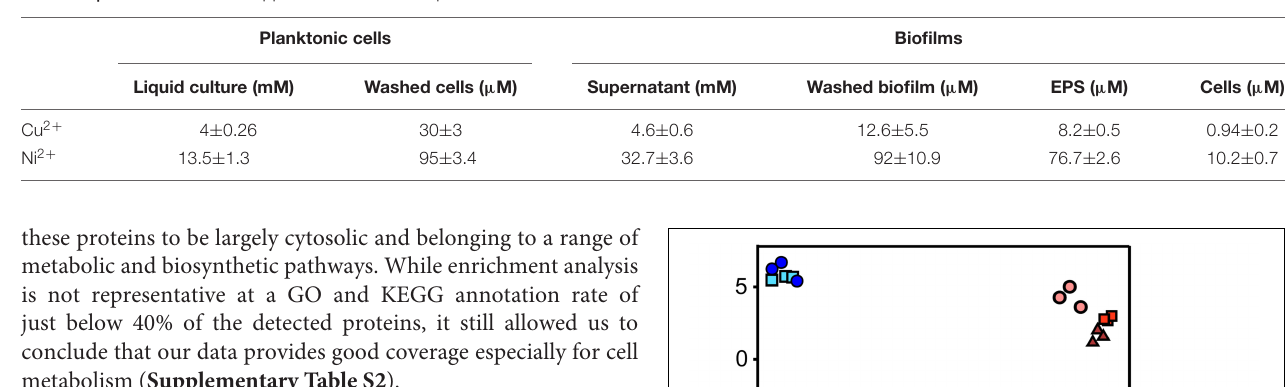
FIGURE 3 | Quantitative investigations on biofilm and EPS composition after exposure to metal ions. (A) Dry mass of lyophilized biofilms and isolated EPS-fractions exposed to Cu 2 + and Ni 2 + . (B) Quantifications of proteins, carbohydrates, and uronic acids in isolated EPS-fractions. The significance of the quantifications of metal ion-treated samples compared to the control was assessed by t -test (ns, not significant, ∗∗ highly significant = p < 0.01, ∗∗∗ extremely significant = p < 0.001). TABLE 1 | Concentrations of copper and nickel ions in planktonic cell cultures and in biofilms.